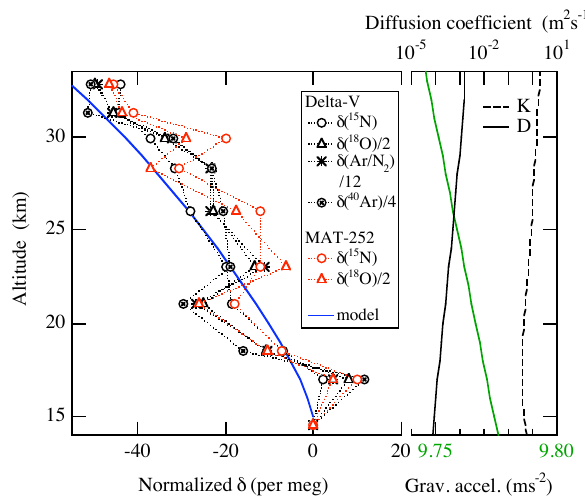
Figure 1. δ ( 15 N) of N 2 , δ ( 18 O)/2 of O 2 , δ (Ar/N 2 )/12 and δ ( 40 Ar)/4 observed over Sanriku, Japan on July 4, 2007. Also shown is the vertical profile of δ value calculated using a 1-dimensional steady state eddy-diffusion/molecular-diffusion model for the mass number difference of 1. The tropopause height on July 4, 2007 was estimated to be about 12 km. The vertical eddy-diffusion coefficient (black dashed line) and molecular-diffusion coefficient (black solid line), and the gravitational acceleration (green solid line) for the model are also shown.